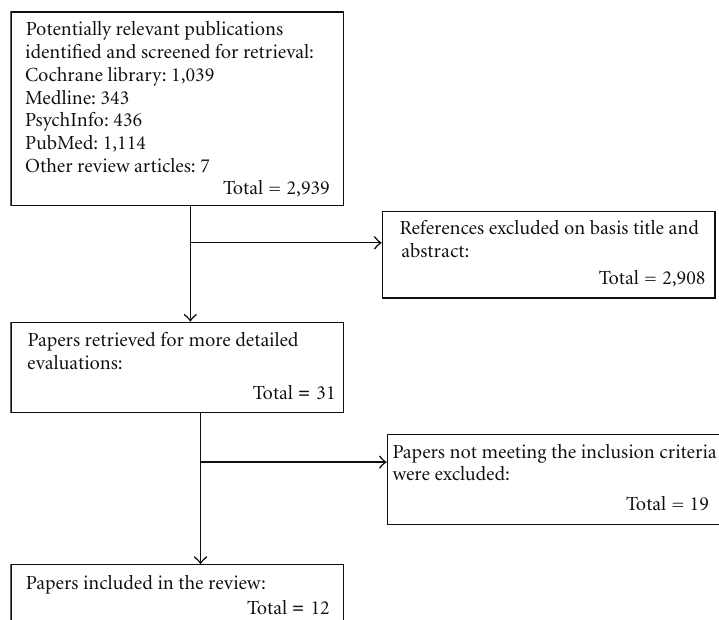
Figure 1: Flow chart of the search